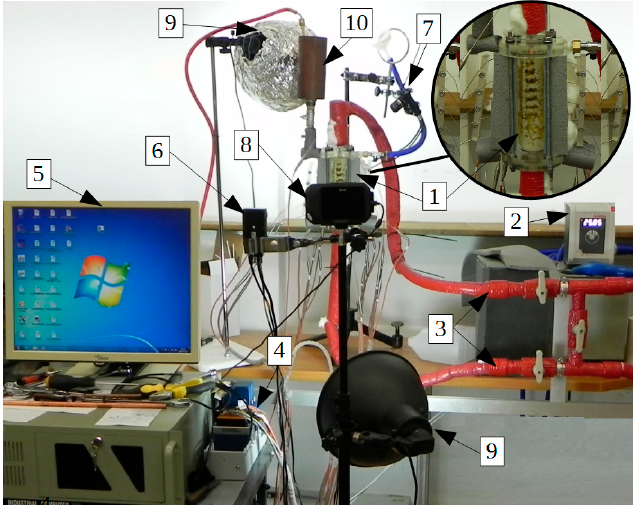
Figure 3. View of experimental test section: 1—experimental module; 2—thermostat with bath; 3—thermostatic loop; 4—data acquisition system; 5—PC; 6—front camera; 7—top camera; 8—thermal imaging camera; 9—photographic lamps; 10—filling vessel.